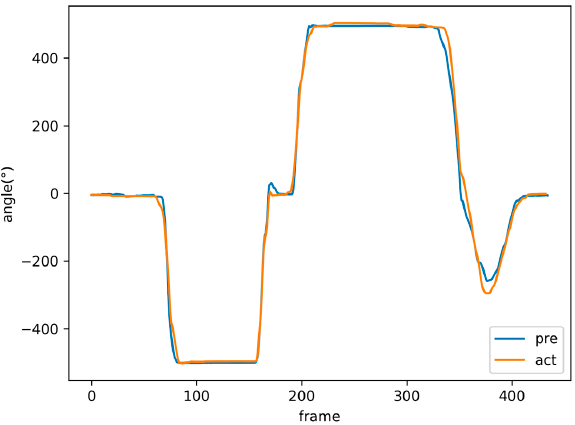
Figure 11. Steering wheel turning angle curve predicted by CNN model.